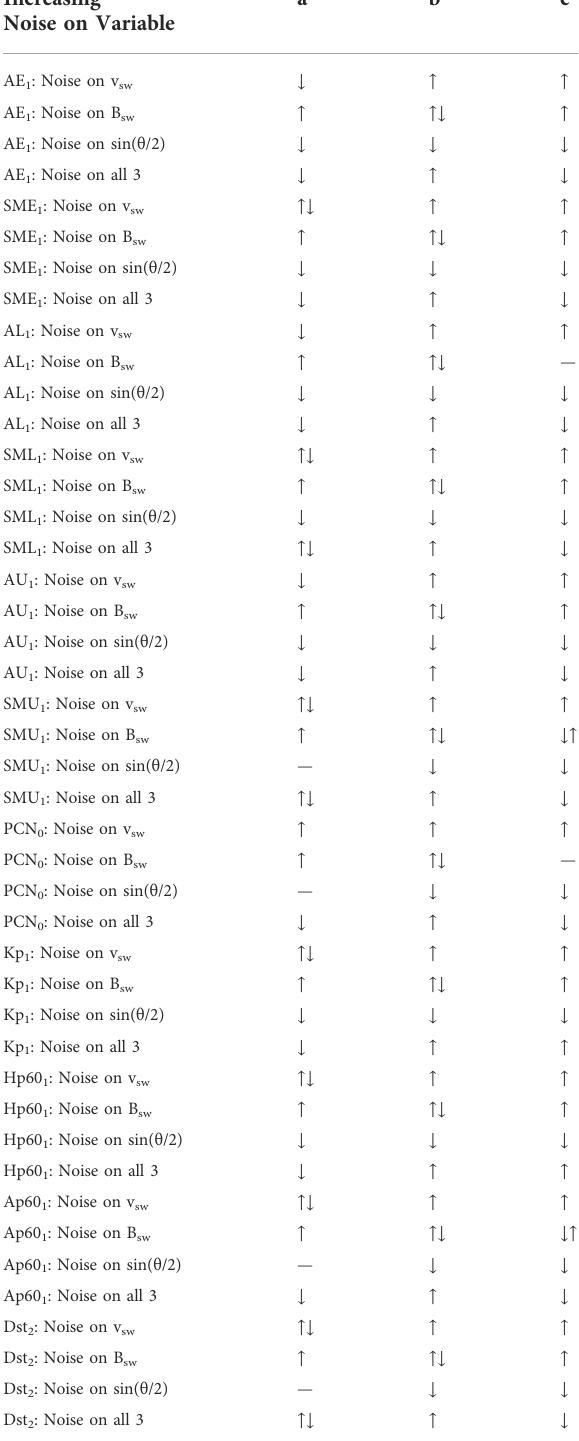
TABLE 1 An increase ( ↑ ) or a decrease ( ↓ ) to the three exponents a, b, and c of D = v sw a B sw b sin c ( θ clock /2) are noted as Gaussian random noise is added to the OMNI2 solar-wind variables for the years 1995 –